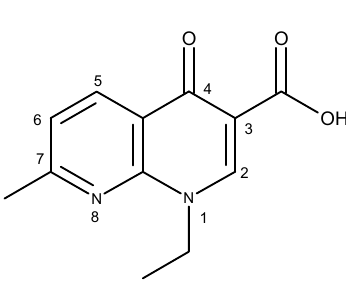
Figure 1. Nalidixic acid.